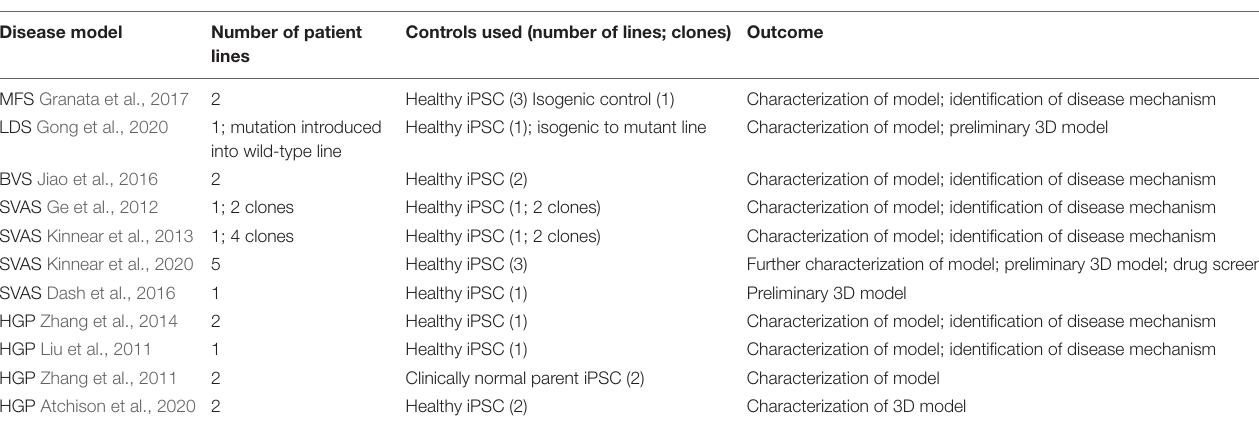
TABLE 1 | Overview of current aortic disease models. Disease model Number of patient Controls used (number of lines; clones) lines